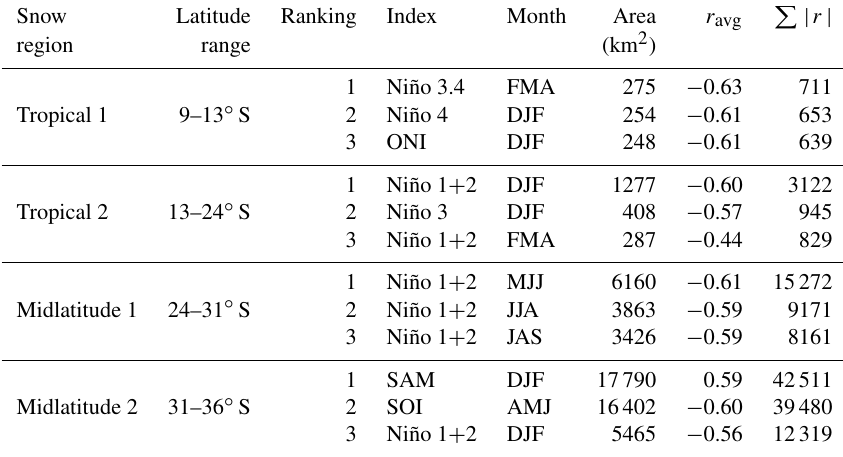
Table 1. Top ranking climate indices for predicting SP by snow region, indicating the average correlation ( r avg ) and the sum of the absolute values of r for each snow region ( P | r |